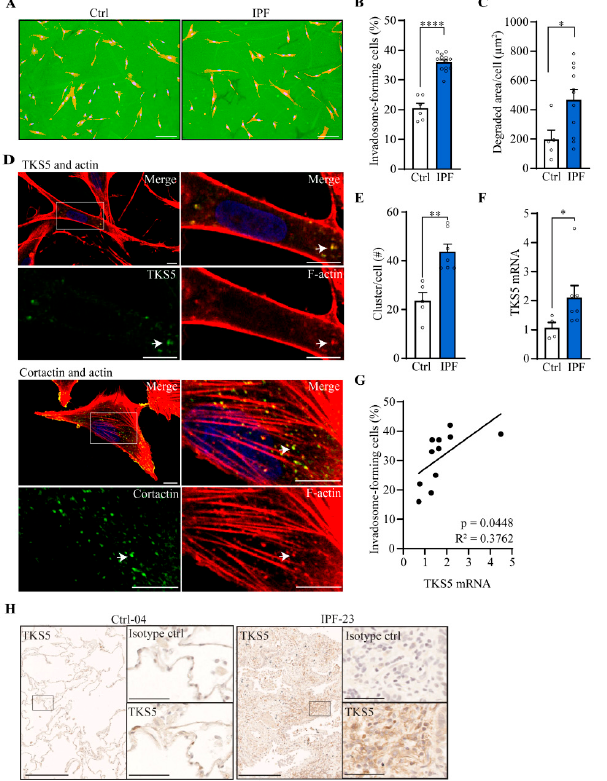
Figure 2. Invadosome formation is increased in lung fibroblasts isolated from IPF patients. Invadosome formation was assessed in fibroblasts from healthy and IPF lung tissues. Each value in the